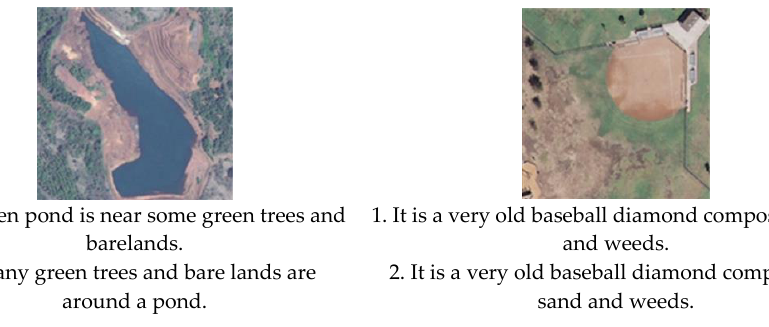
Figure 8. The captions generated by our model after training on the unmodified and modified datasets. The sentence 1 uses the unmodified datasets, and the sentence 2 uses the modified datasets. Underlined words represent where the caption is wrong.